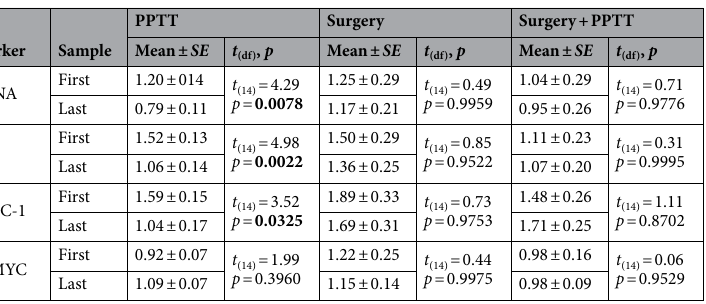
Table 4. Comparison between AAbs values measured before treatment (first) and after treatment (last). Significant results at p < 0.05 if (bold).